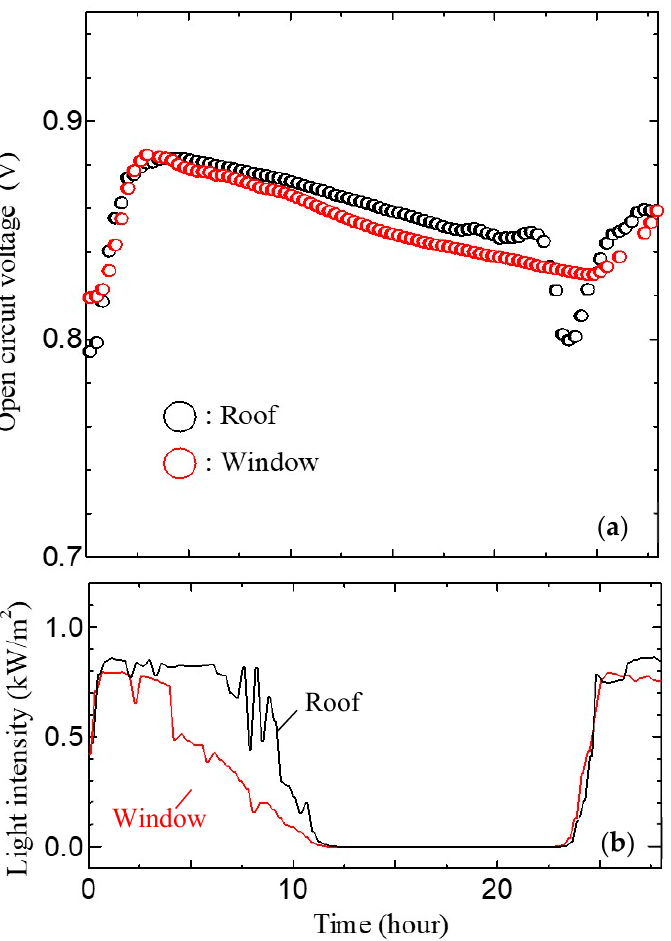
Figure 8. Typical time dependence of daily OCVs ( a ) and light intensity by sunshine ( b ).